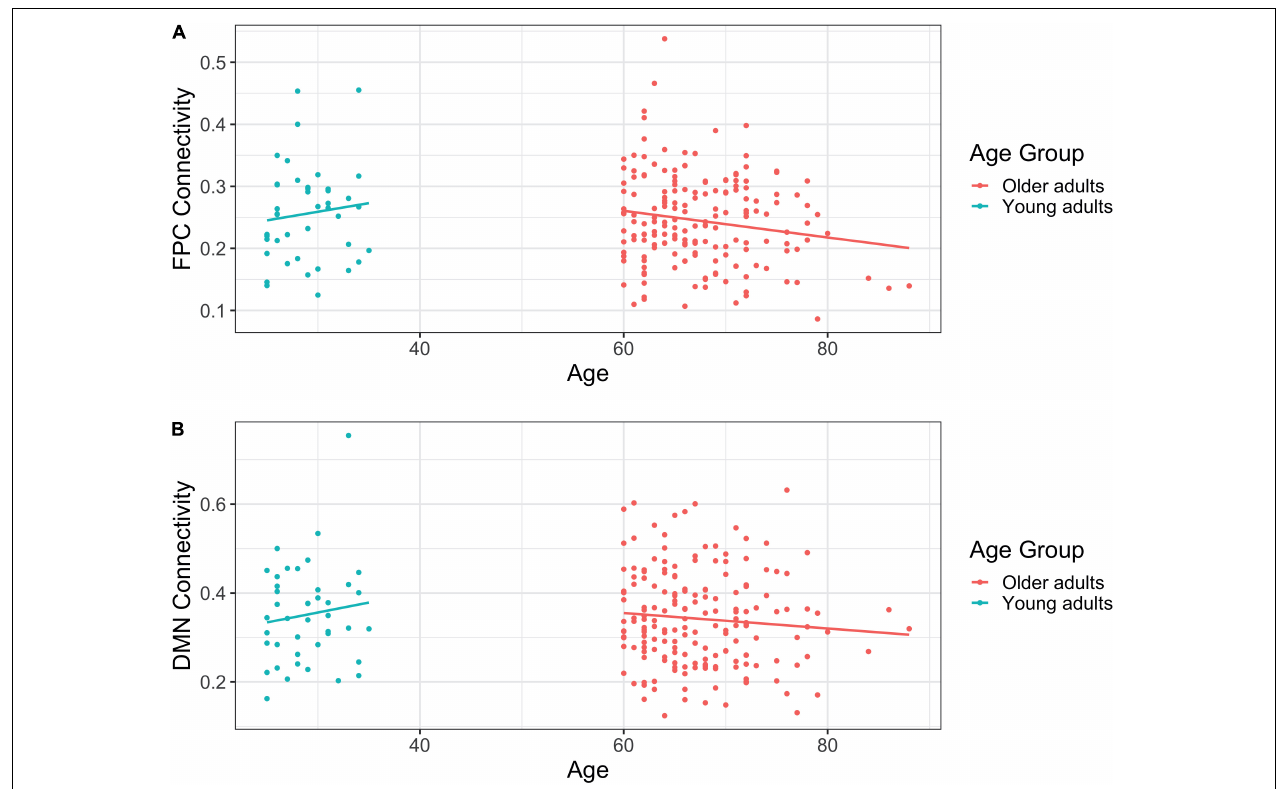
FIGURE 1 | (A) Scatterplot of frontoparietal control network (FPCN) connectivity by self-reported age in years. (B) Scatterplot of default mode network (DMN) connectivity by self-reported age in years.